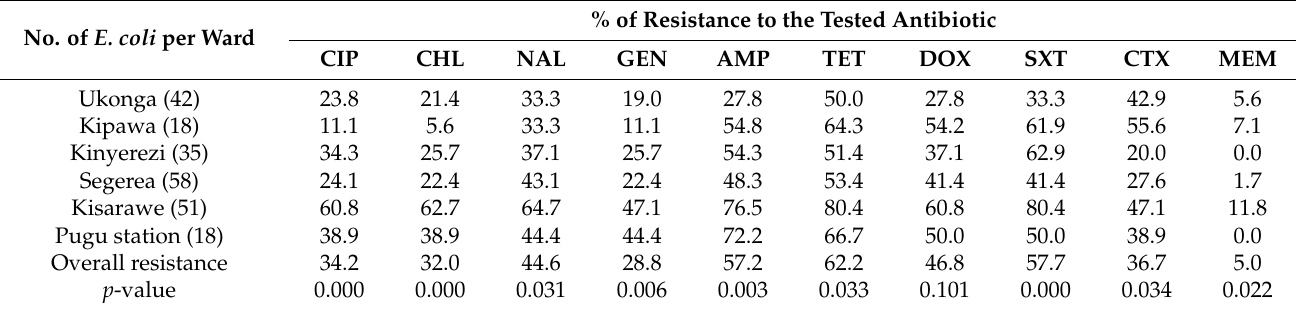
Table 4. Prevalence of antibiotic-resistant E. coli from domestic pigs by